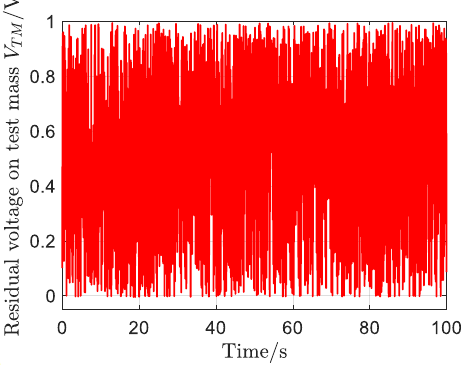
Figure 11. Time response of the residual voltages of the test mass.